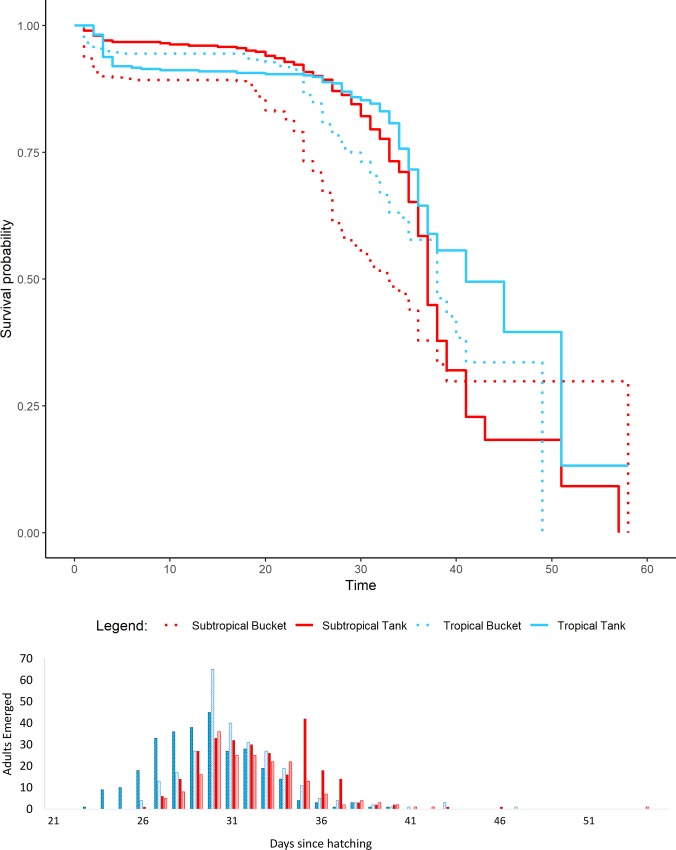
Survival curves and time to emergence of surviving adults comparing tropical (blue) and subtropical (red) Aedes aegypti strains in tank (solid fill) and bucket (spotted fill) temperature treatments.